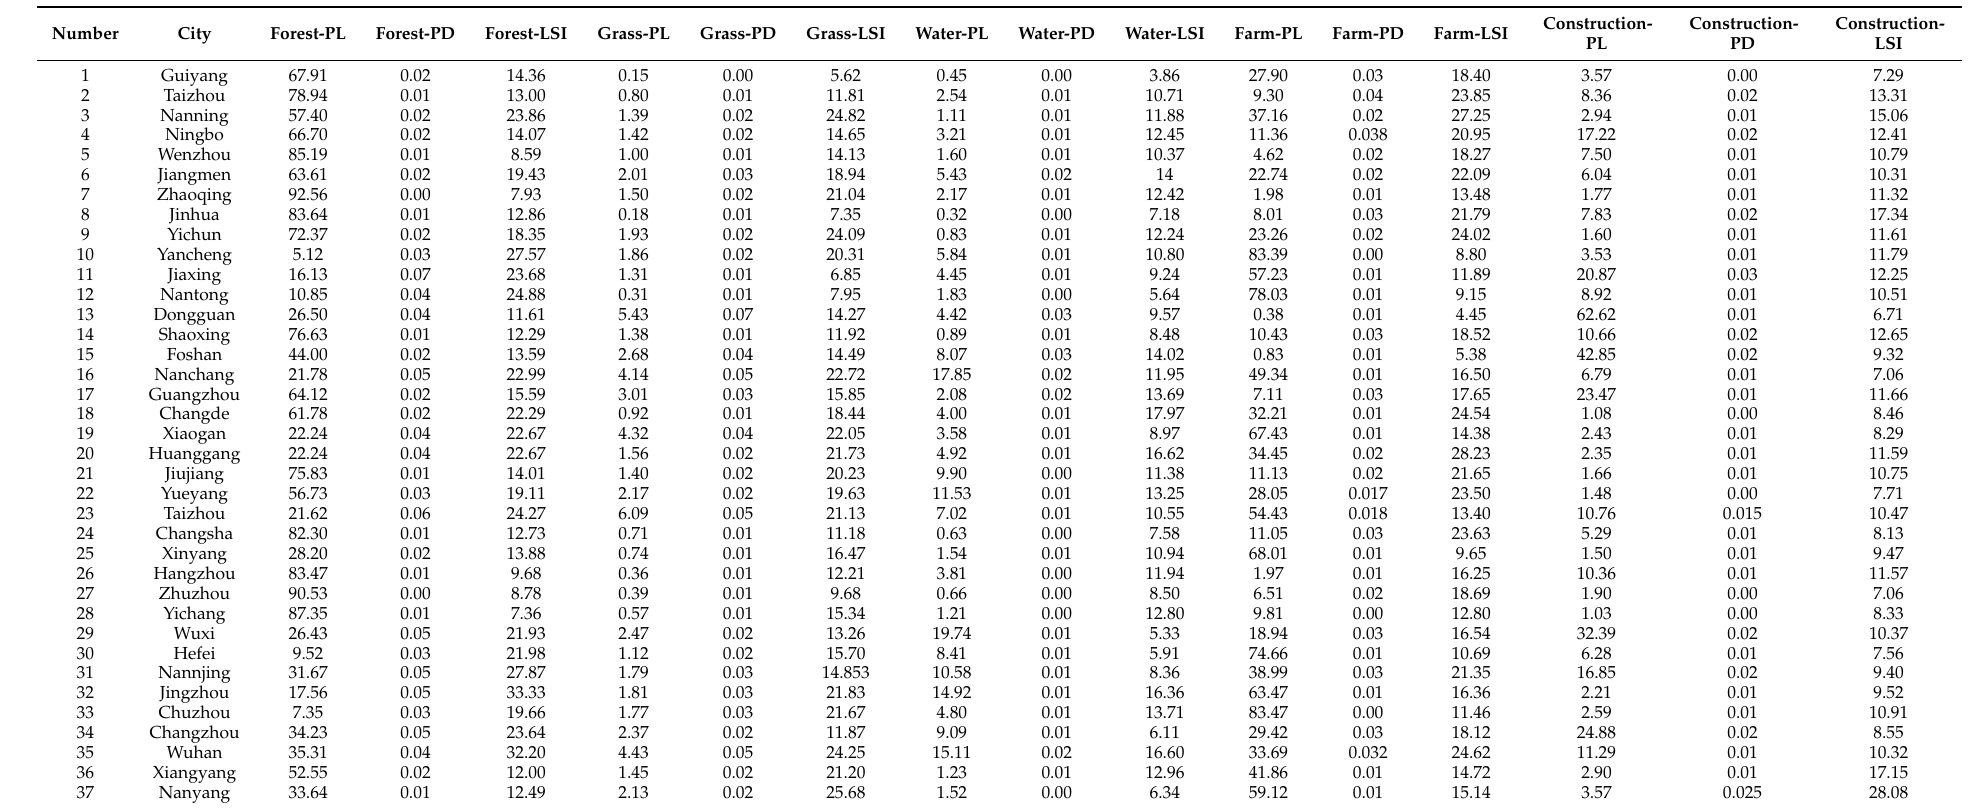
Table A2. The data for patch-level landscape pattern